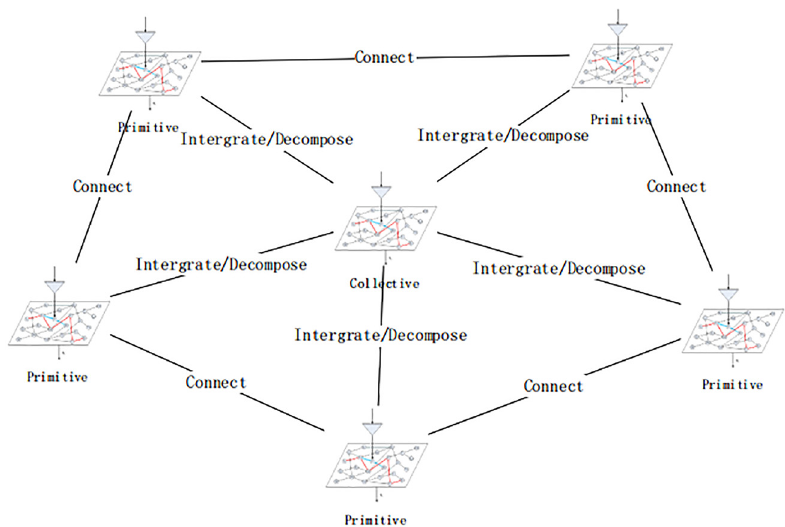
Figure 3. Structure of swarm intelligence unit